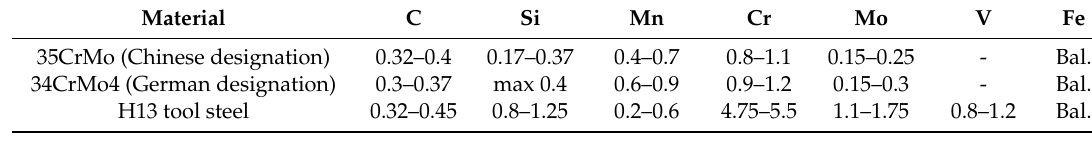
Table 2. Chemical composition of 35CrMo, 34CrMo4 and H13.